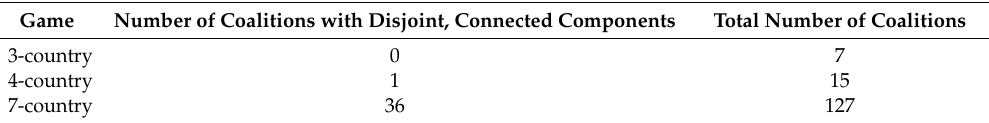
Table 6. Coalitions with disjoint, connected components.